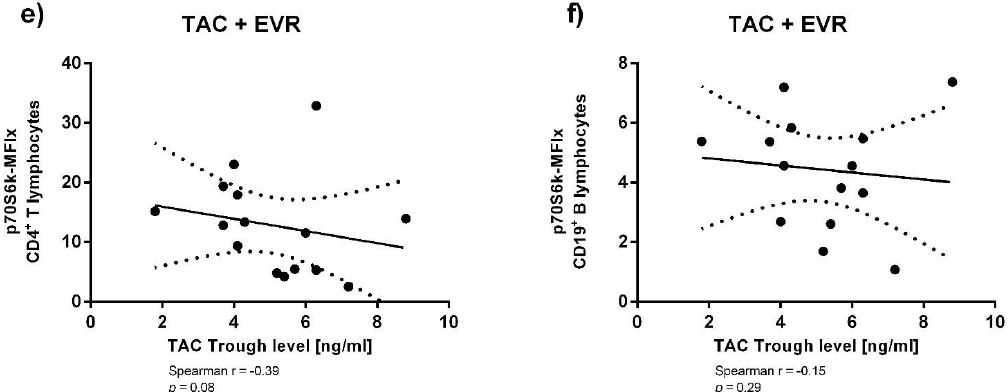
Figure A2. TAC trough levels showed a statistically significant correlation with p70S6k phosphorylation as measured in ( a ) CD4 + T lymphocytes and ( b ) CD19 + B lymphocytes when analyzing all patients receiving TAC. However, in the analysis of the subgroup of patients ( n = 4) receiving TAC without an mTORi no statistically significant positive correlation was found in both ( c ) CD4 + T lymphocytes and ( d ) CD19 + B lymphocytes. The subgroup receiving a combination of TAC and an mTORi showed no significant correlation between TAC trough levels and p70S6k phosphorylation in ( e ) CD4 + T lymphocytes and ( f ) CD19 + B lymphocytes either (* meaning p < 0.05; ** meaning p <